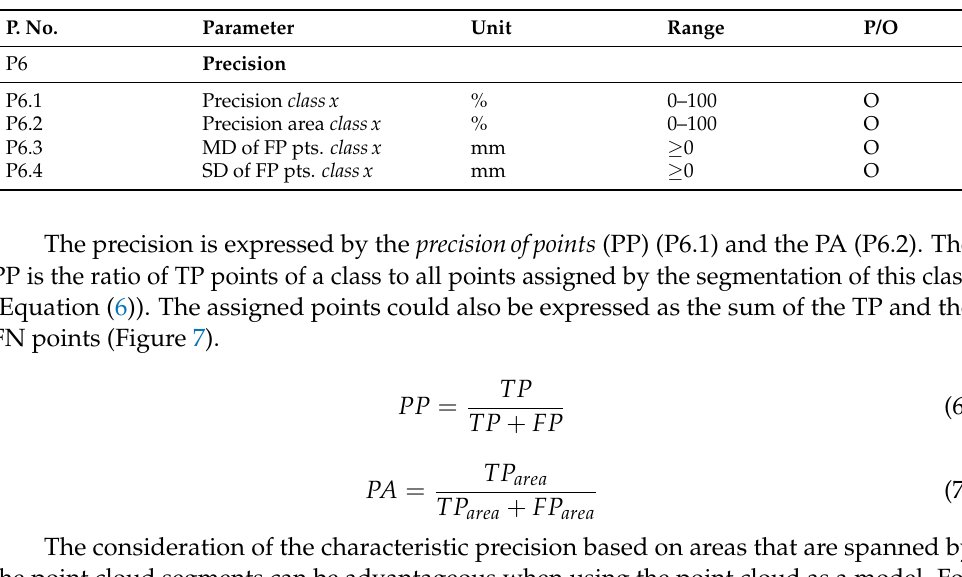
Figure 7. Schematic representation of the confusion matrix for the floor class with entries for TP, FN, FP and true negative (TN) points. Table 10. Parameters for